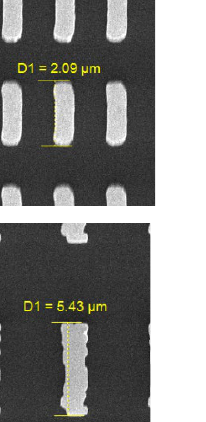
Table 1. Calculation of wavelength values for basic dipole modes of the complementary